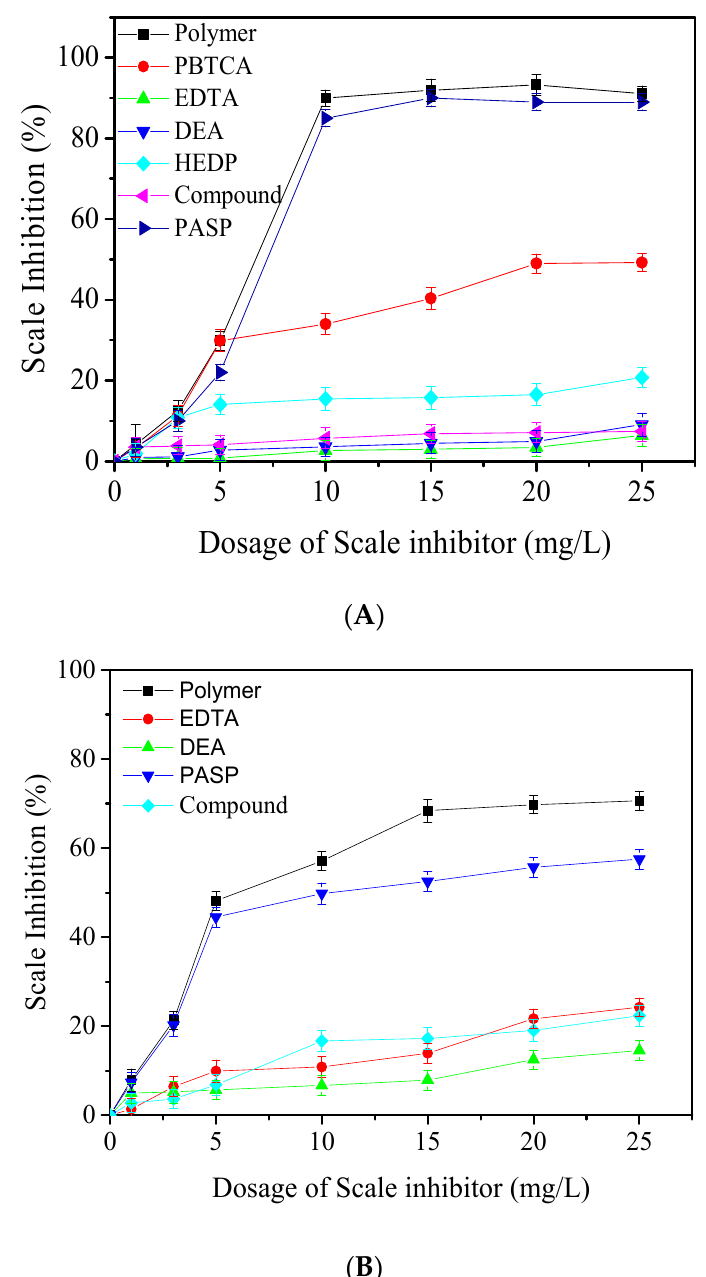
Figure 4. Precipitation inhibition performances of polymer, the commercial scale inhibitor and monomer on calcium sulfate ( A ), and calcium carbonate ( B ).